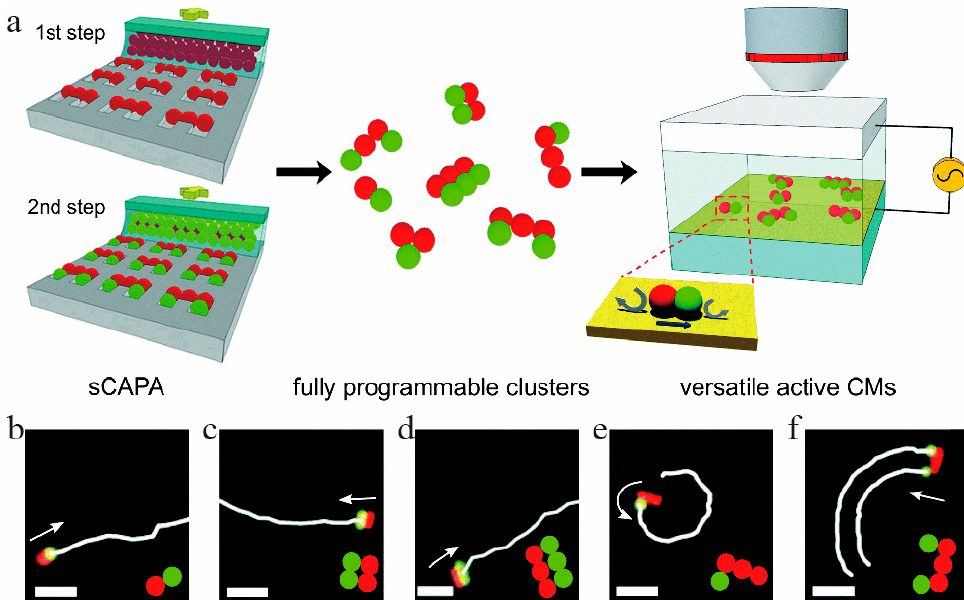
Figure 2. Motion of a micro-semiconductor diode. ( a ) The fabrication of active colloidal molecules by sCAPA. Under the vertical AC field, an asymmetric electro-hydrodynamic (EHD) flow is generated, which pushes the CMs to perform ( b – d ) linear, ( e ) rotational and ( f ) circular movement at different speeds. The figure has been reproduced with permission from the Royal Society of Chemistry [115]. sCAPA in the figure refers to sequential capillarity-assisted particle assembly, CMs in the figure refers to “colloidal molecules”.